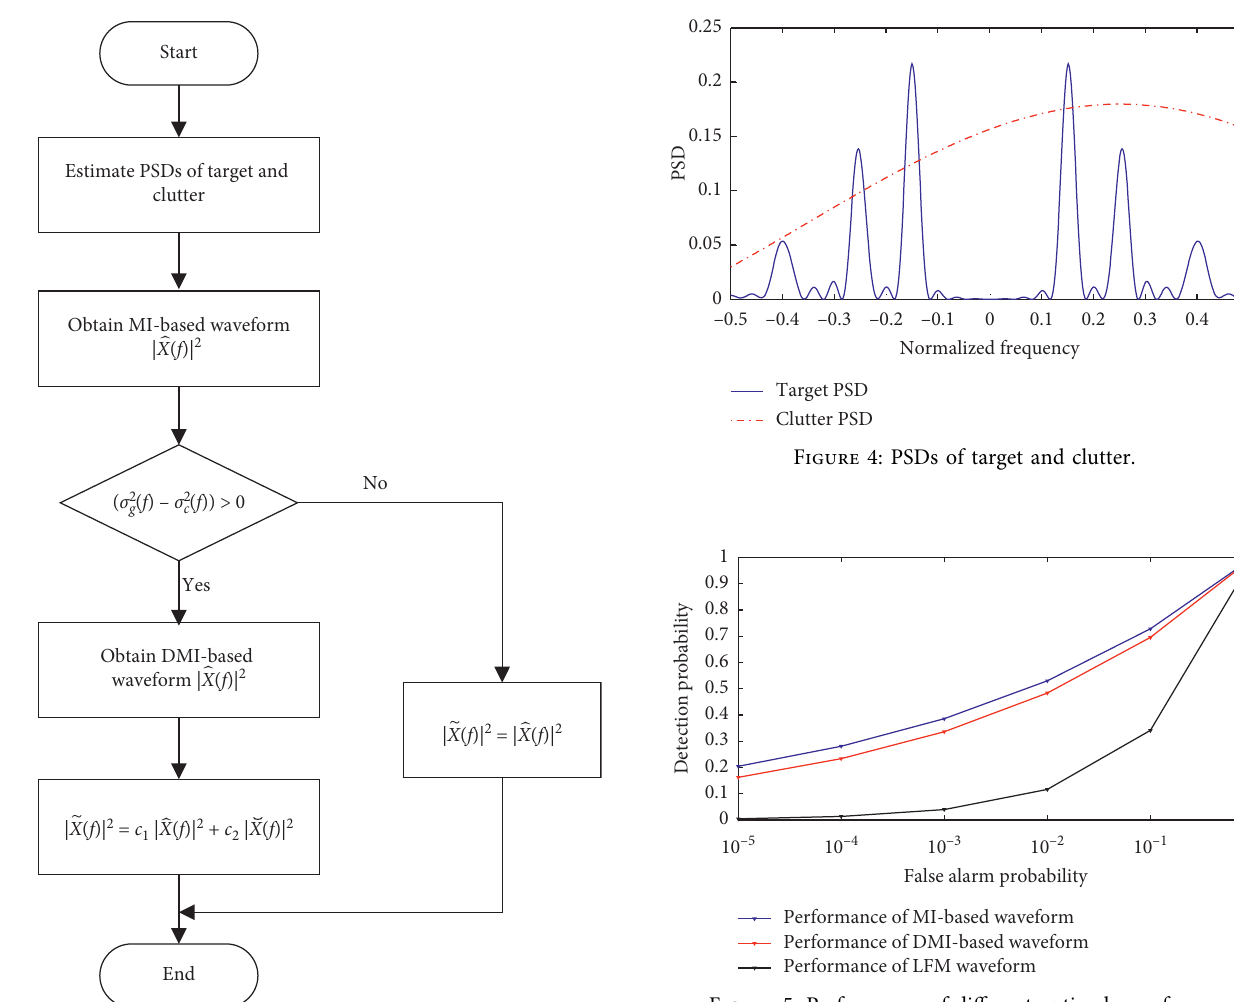
Figure 5: Performance of different optimal